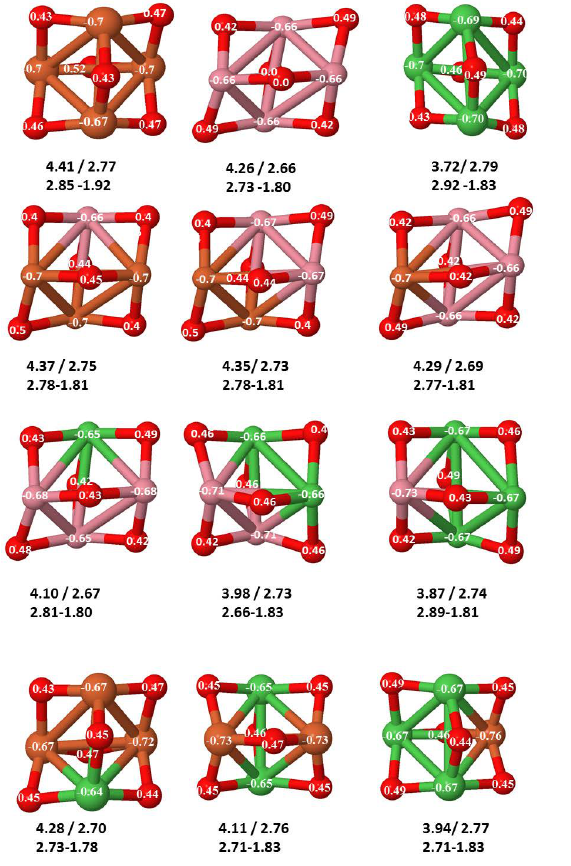
Figure 11. (Color online) Ground states of A 4 − x B x O 6 (A, B = Fe, Co, Ni; x = 0–4) oxides. The excess (or defect) of the electronic charge for Fe, Co and O is given for each atom. Positive (negative) numbers indicate excess (defect). Below each of the structures, there are two rows of numbers. In the first one, binding energy per atom (in eV) and average electronic charge transfer (in e ) are given. In the second one, both average TM–TM and TM–O distances are given. Fe atoms in brown color, Co atoms in pink, Ni atoms in green color and oxygen atoms in